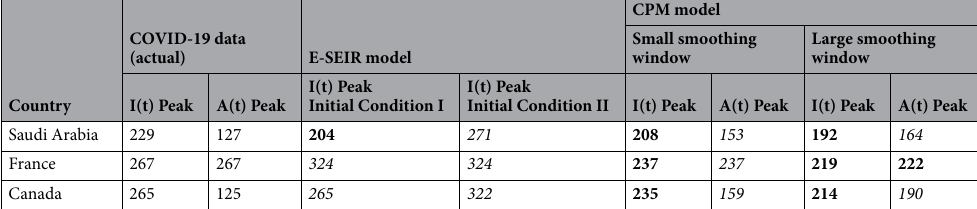
Table 6. E-SEIR and CPM Models peaks predictions time location (in days) comparison. Each Bold cell indicates that the prediction falls before the corresponding actual peak (i.e., not realistic). In contrast, each italics cell indicates that the prediction falls after the corresponding actual peak (i.e.,